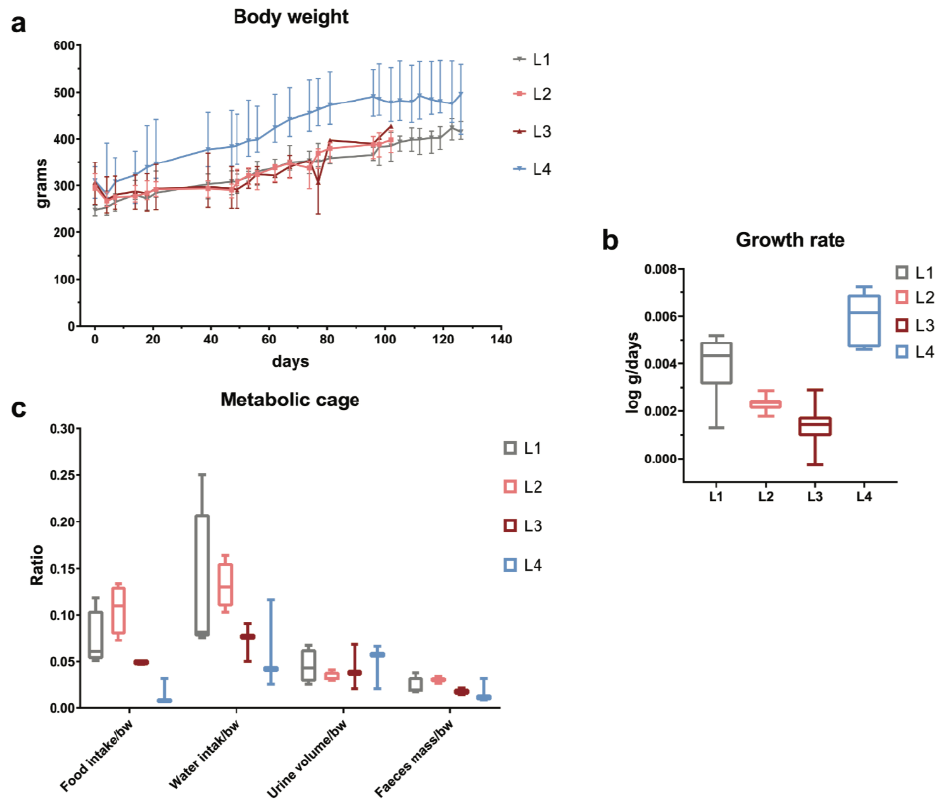
Figure 1. Clinical monitoring by body weight ( a , b ) and metabolic cage ( c ) where doxorubicin toxicity became apparent in L2 and L3 groups by reducing growth rate and influencing eating behavior, while in L4 rats an increase in growth rate despite reduced food and water intake was ob- served.